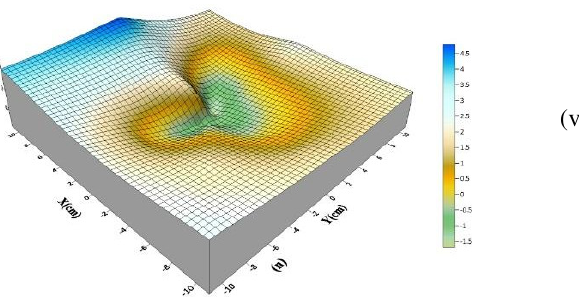
Fig. 8(n): The Scour and Deposition Pattern around Pier (P 2 ) at angle 19 0 and flowrate 14L/Sec.